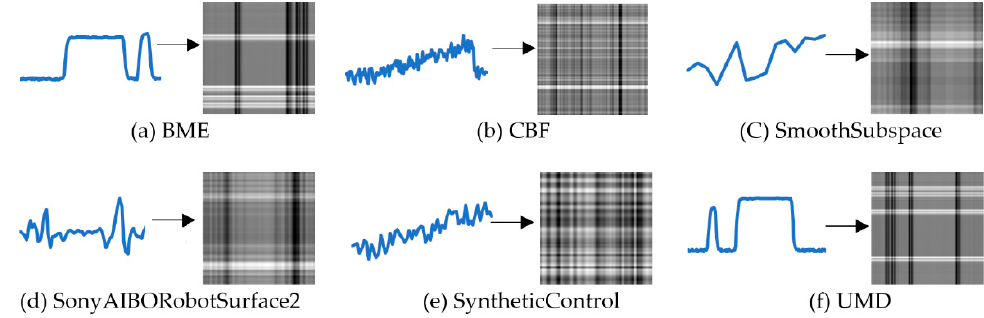
Figure 2. The effect of converting six UCR datasets into the grayscale image. The grayscale images intuitively present the general changes of different